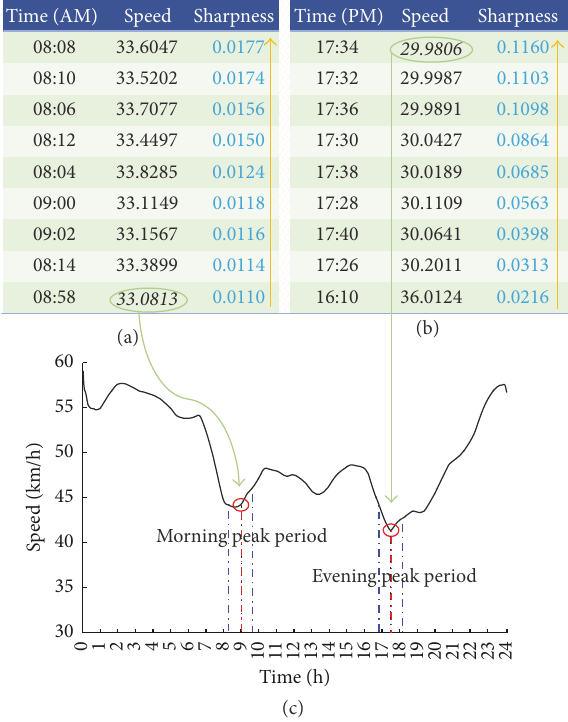
Figure 3: The peak points in the speed curve: (a) sorted traffic samples in the estimated morning peak period; (b) sorted traffic samples in the estimated evening peak period; (c) two peak points on the speed curve.